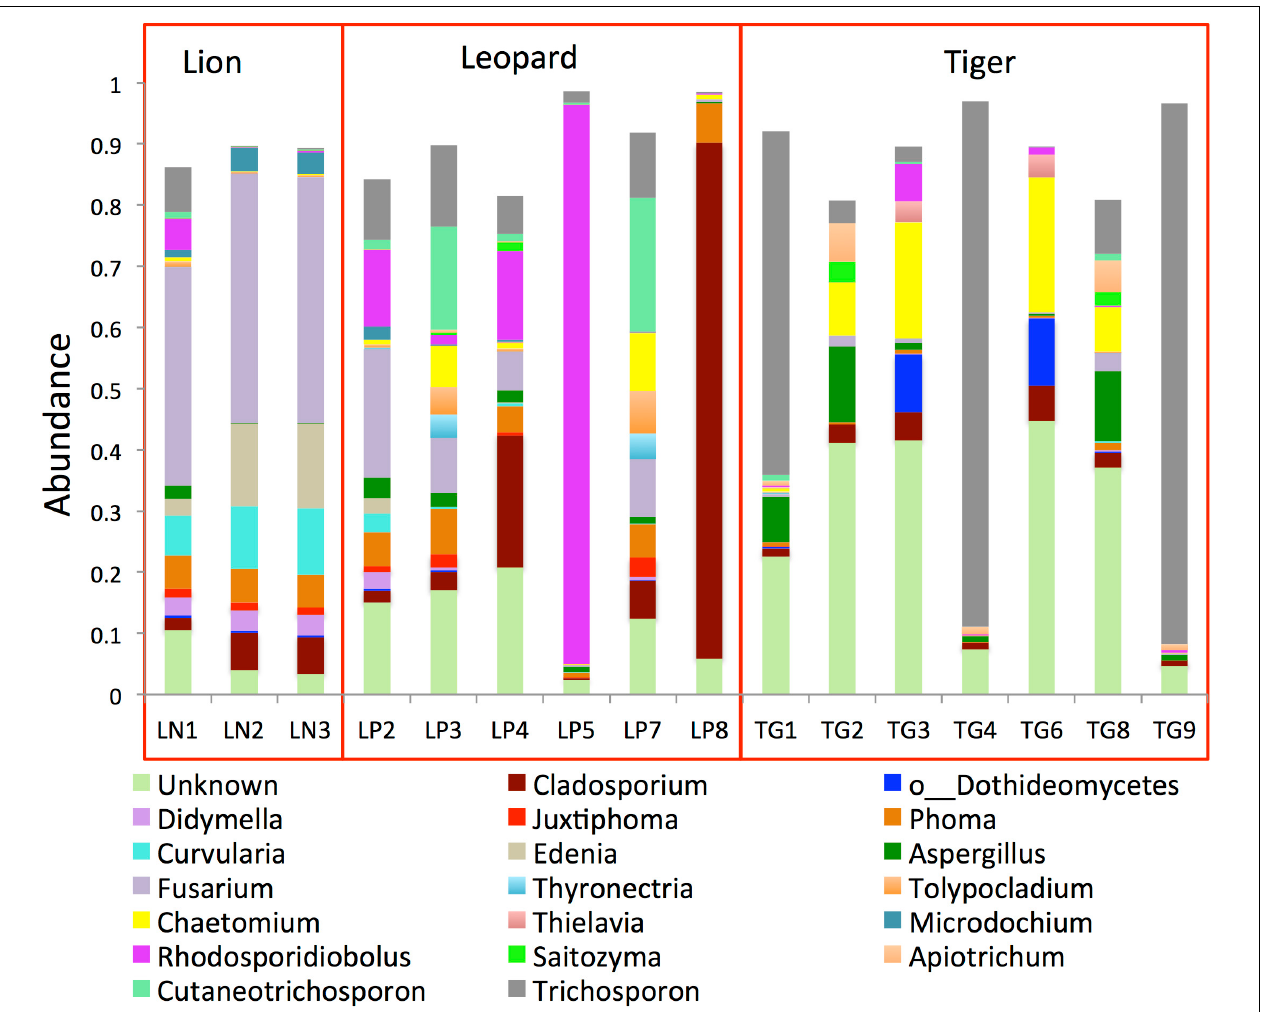
FIGURE 3 | Bar plots showing the topmost abundant fungal genera present in the Panthera gut microbiome. The genera with more than 1% abundance are